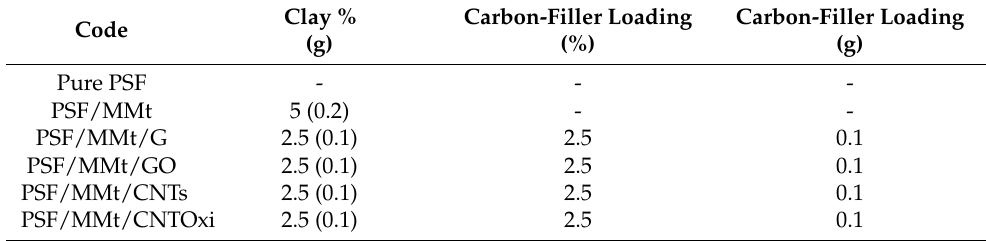
Table 1. Suggested list of abbreviations, codes and compositions for the fabricated